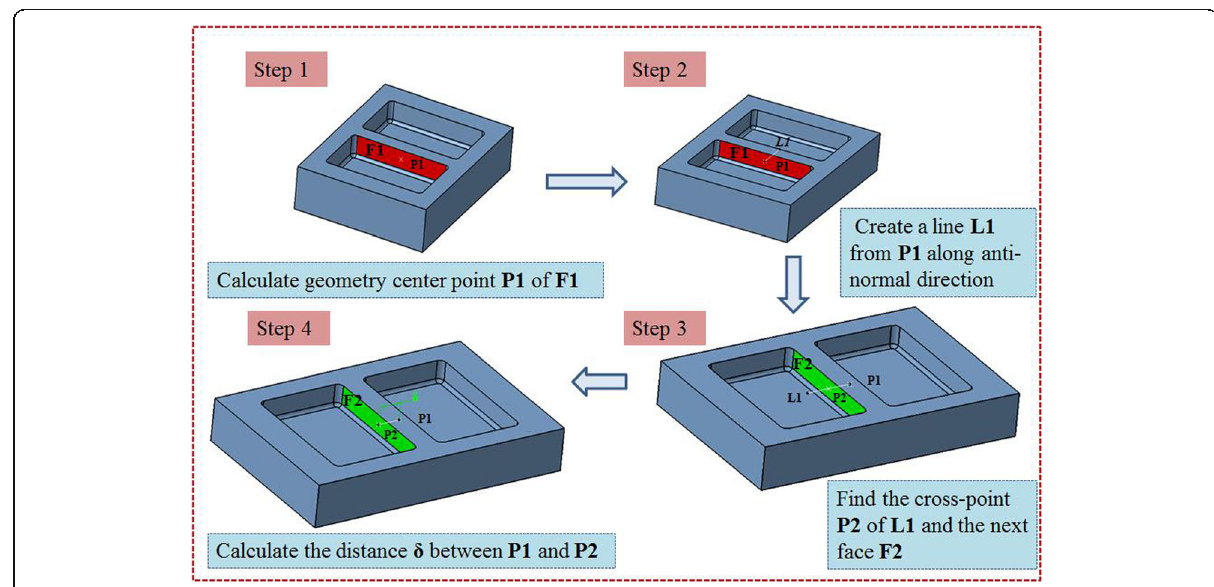
Fig. 5 Wall thickness calculation process of machining